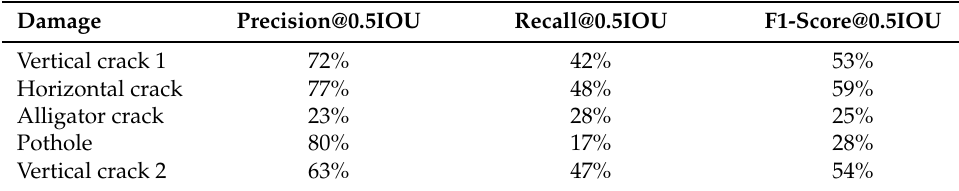
Table 5. Precision and recall of Model 3.